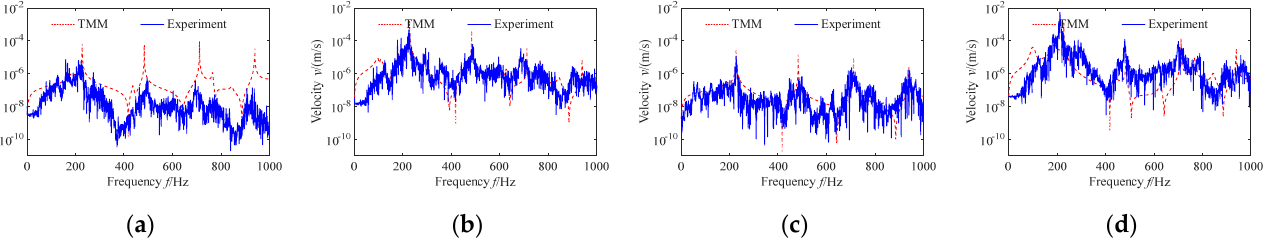
Figure 14. Velocity responses of pipe (case 2). ( a ) Axial velocity of point A. ( b ) Radial velocity of point A. ( c ) Axial velocity of point B. ( d ) Radial velocity of point B. Table 10. Resonant frequencies of pipe (case 2).